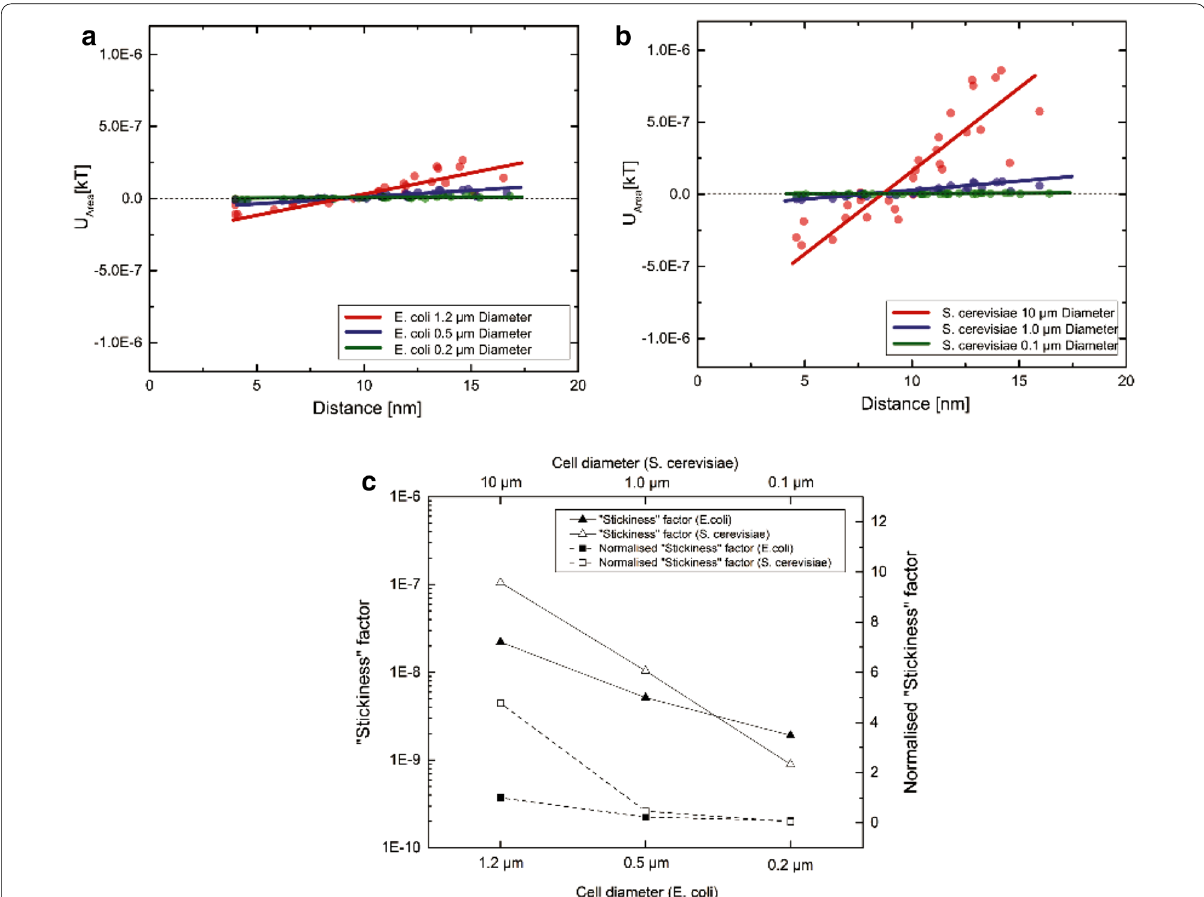
Fig. 5 Effect of particle size on interaction surface a with E. coli, b with yeast interaction is presented; c comparison of “Stickiness” factor change with particle size and cell